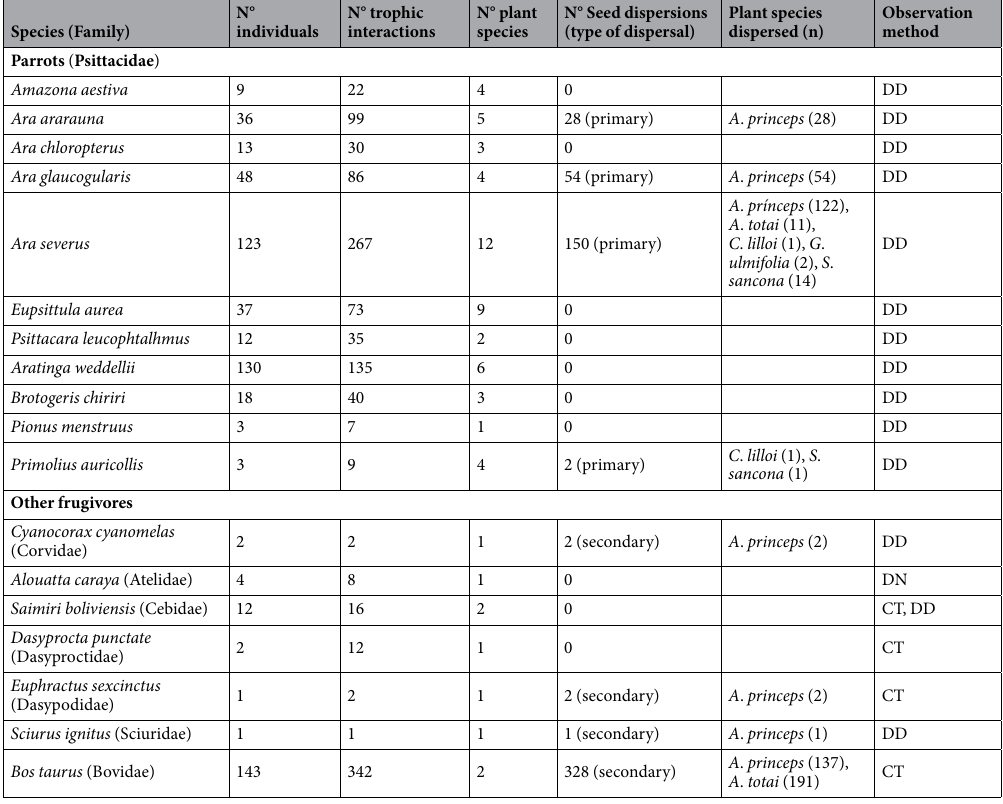
Table 1. Number of individuals, trophic interactions events and plant species involved in the observations of each frugivorous species recorded feeding on large fruits or seeds in the Beni biome. All seed dispersions are stomatochorous dispersal events (both primary and secondary), except for cow Bos taurus that refers to secondary endozoochorous dispersal events. The number of seed dispersals of each plant species conducted by each frugivorous species is also shown. Observation methods differ in sampling effort: Direct-Diurnal (DD) = 420 hours, Direct-Nocturnal (DN) = 60 hours, Camera trap (CT) = 2320